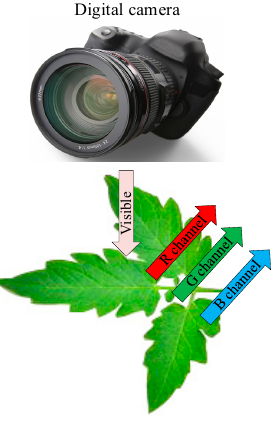
Figure 4. Basic principles of the machine vision technology.